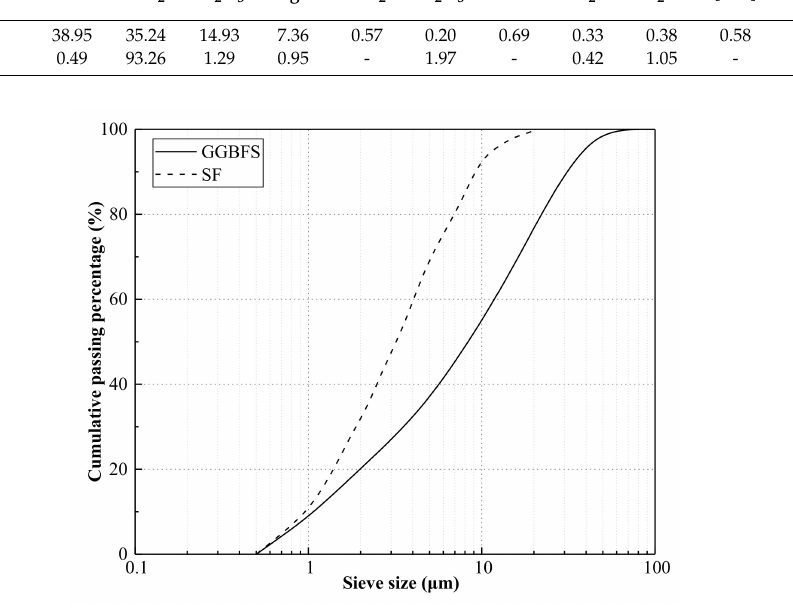
Figure 1. Particle size distribution of the GGBFS and